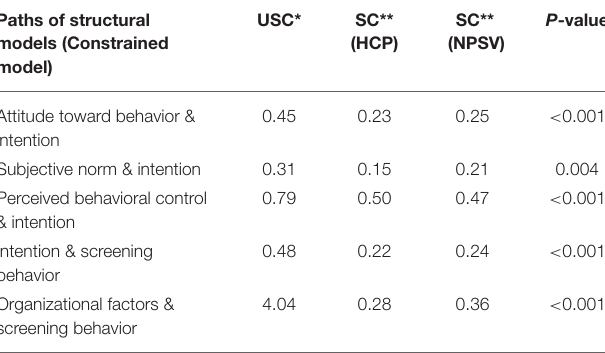
TABLE 5 | Path coefficients of the multi-group SEM with organizational expansion. Paths of structural models